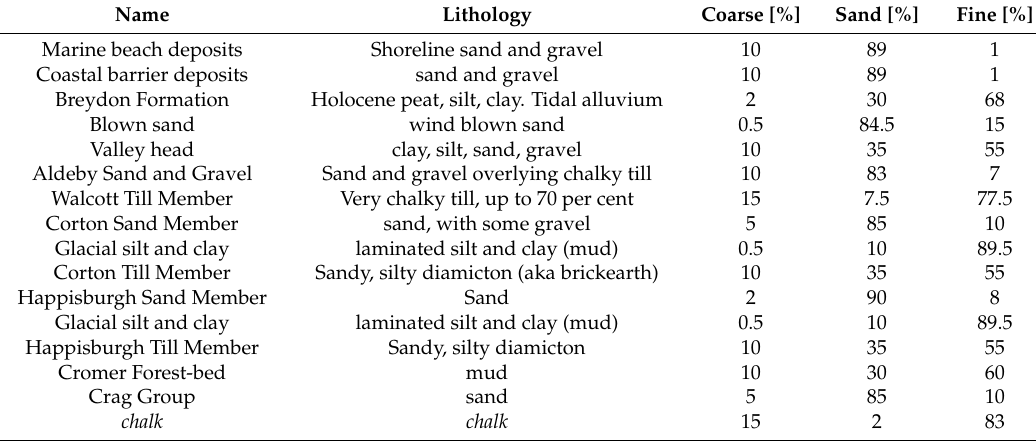
Table A3. Assigned average percentages for fines (<0.63 mm), sand (0.63–2 mm) and coarse material (>2 mm) for the different lithostratigraphical units expressed in the 3D subsurface